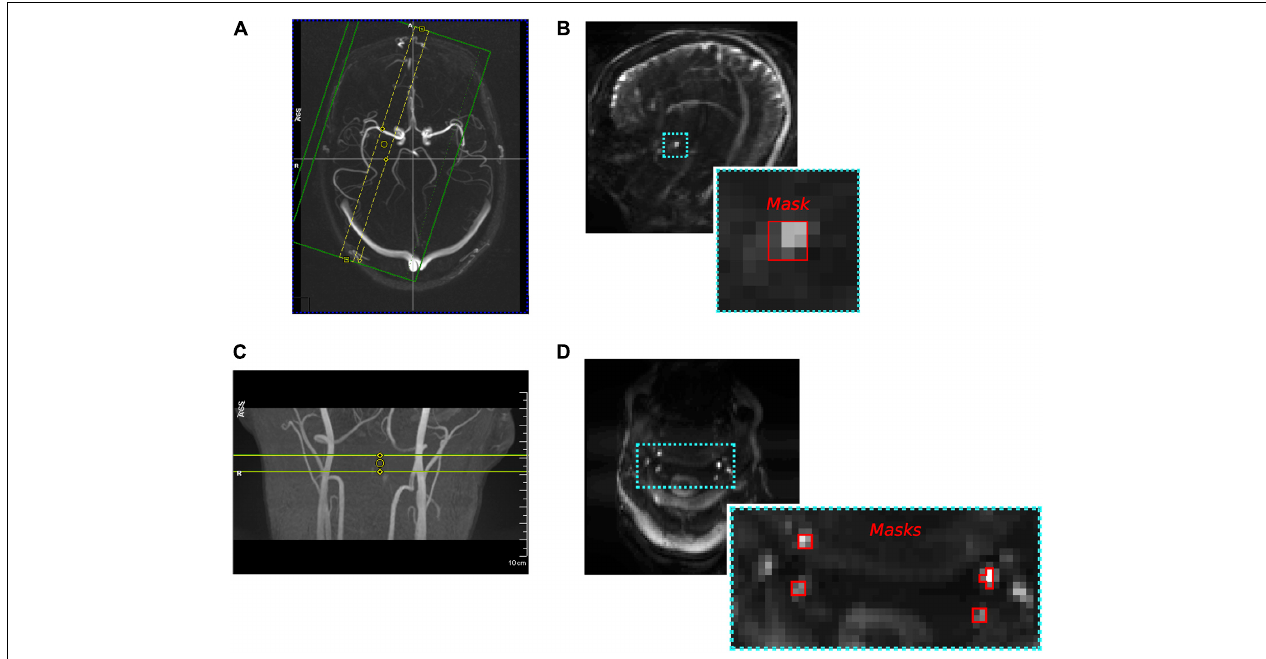
FIGURE 1 | (A) An example of the slice placement at the M1 segment of the MCA for the “Hypercapnia Challenge-Experiment”. (B) An example dynamic inflow magnitude contrast (DIMAC) image, including MCA mask. (C) Slice placement for the subject in the “Thigh Cuff Release-Experiment” placed to include best perpendicular placement of bilateral ICAs and VAs. (D) Subject’s DIMAC EPI image and artery